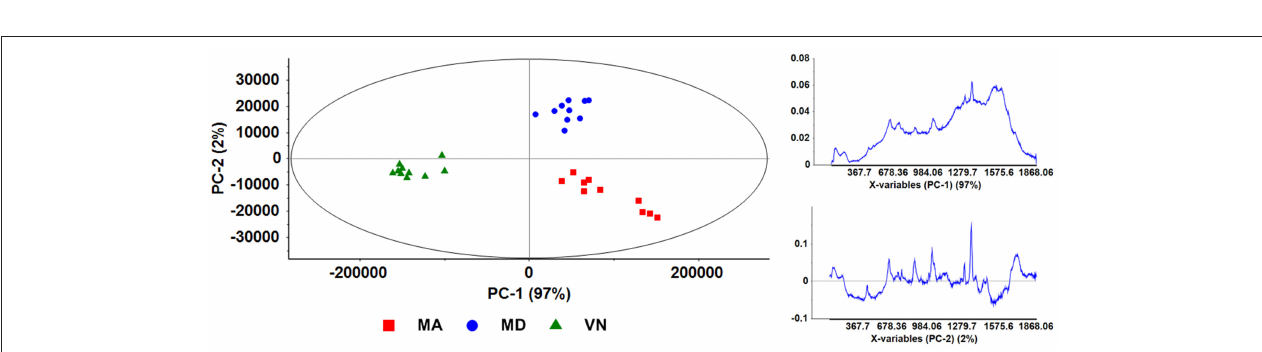
FIGURE 5 | Scores plot depicting PC-1 and PC-2 (left); and loadings plots (right) for both Principal Components, PC-1 (top), and PC-2 (bottom). These plots are for SERS spectra obtained from samples prepared following the overnight incubation protocol, with data pre-treatment by BLC.